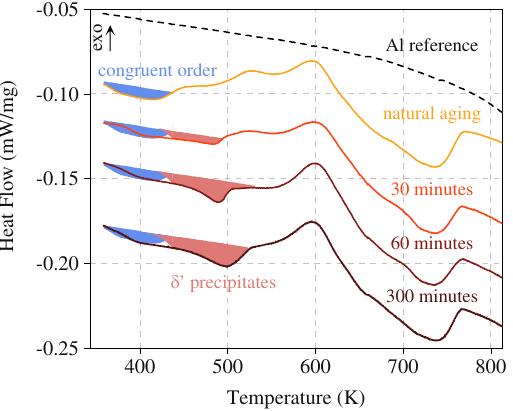
Figure 6. DSC measurements of the Al-Cu-Li model alloy in 4 heat treatment conditions (naturally aged as well as 30 minutes, 60 minutes and 300 minutes artificially aged at 433